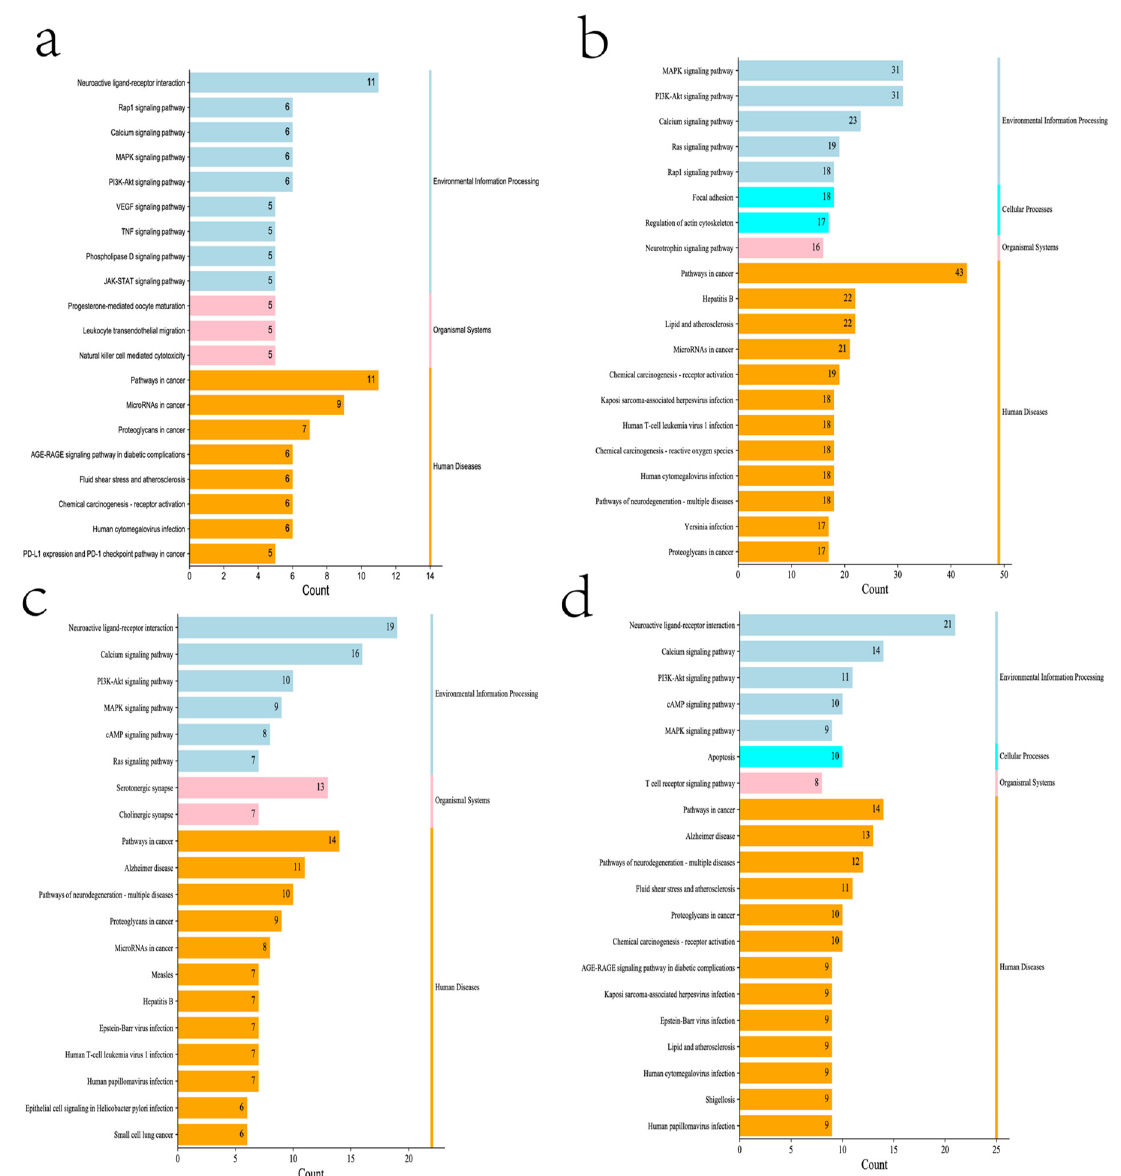
Figure 7. KEGG enrichment analysis of four components of Tanshinone (( a ): Tanshinone Ir; ( b ): Tanshinone IIA; ( c ): Dihydrotanshinone I; ( d ): Cryptotanshinone).